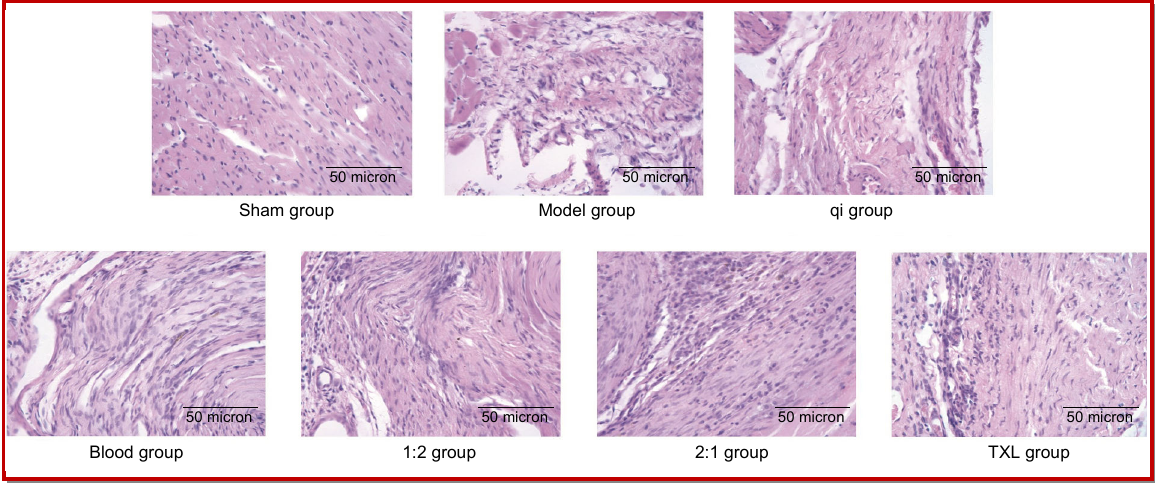
Figure 1: Microscopic view of cardiac muscle after HE staining in different